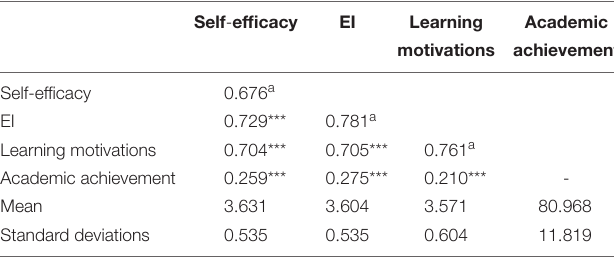
TABLE 2 | The AVE and correlation coefficients of all variables ( N = 404).